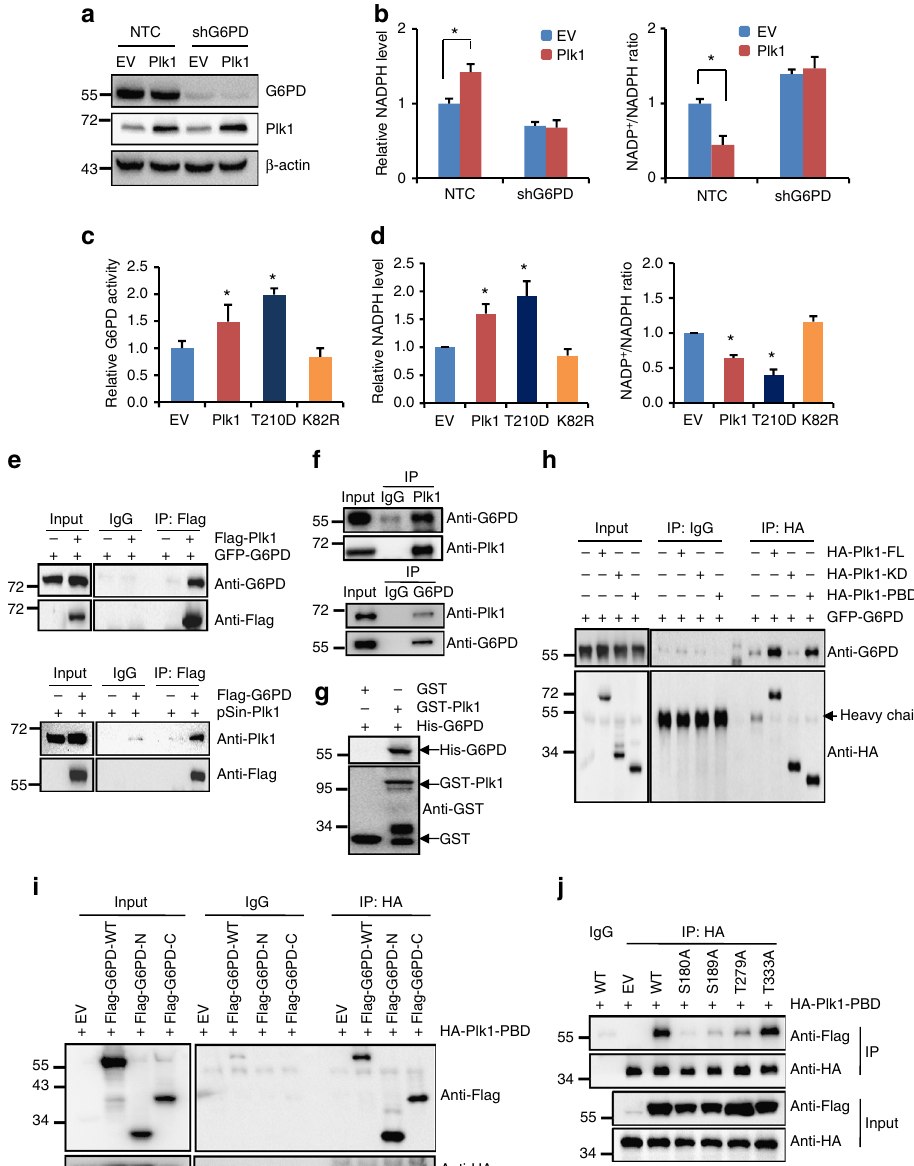
Fig. 3 Plk1 regulates G6PD activity by interacting with G6PD. a , b HeLa cells stably overexpressing EV or Plk1 were further infected with viruses expressing NTC or shG6PD. Plk1 and G6PD protein ( a ), and relative NADPH and NADP + /NADPH ratio levels ( b ) were determined. n = 3 biologically independent replicates. Data were presented as mean ± s.d. * P < 0.05 as compared between indicated groups by two-sided Student ’ s t -test. c , d HeLa cells were stably overexpressing EV or Plk1 wild type or its T210D or K82R mutants. G6PD activity ( c ), and relative NADPH and NADP + /NADPH ratio levels ( d ) were determined. n = 3 biologically independent replicates. Data were presented as mean ± s.d. * P < 0.05 as compared to EV group by two-sided Student ’ s t - test. ( e ) 293T cells were transfected with eGFP-G6PD plasmids alone or together with Flag-Plk1 plasmids. Or 293T cells were transfected with pSin-Plk1 plasmids alone or together with Flag-G6PD plasmids. Cell lysates were immunoprecipitated with anti-Flag antibody or IgG, followed by western blot analysis. f HeLa cells were harvested and subjected to immunoprecipitation with anti-Plk1 or anti-G6PD, followed by western blot analysis with anti-Plk1 and anti-G6PD. g GST pull down of His-G6PD by GST-Plk1 using proteins puri fi ed in E. coli bacteria, followed by western blot analysis with anti-G6PD and anti-GST antibodies. h 293T cells were transfected with eGFP-G6PD plasmids alone or together with HA-tagged plasmids expressing Plk1 full length or its kinase domain or polo-box domain. Cell lysates were immunoprecipitated with anti-HA antibody or IgG, followed by western blot analysis. i 293T cells were transfected with vectors expressing HA-Plk1-PBD and Flag-G6PD wild type or its truncated mutants as indicated. Cells were then harvested